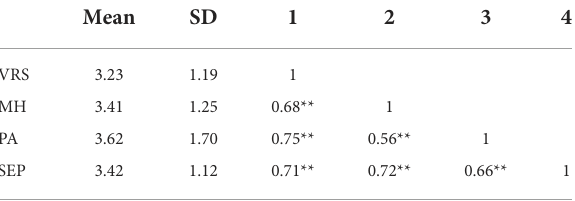
TABLE 2 Descriptive statistics and